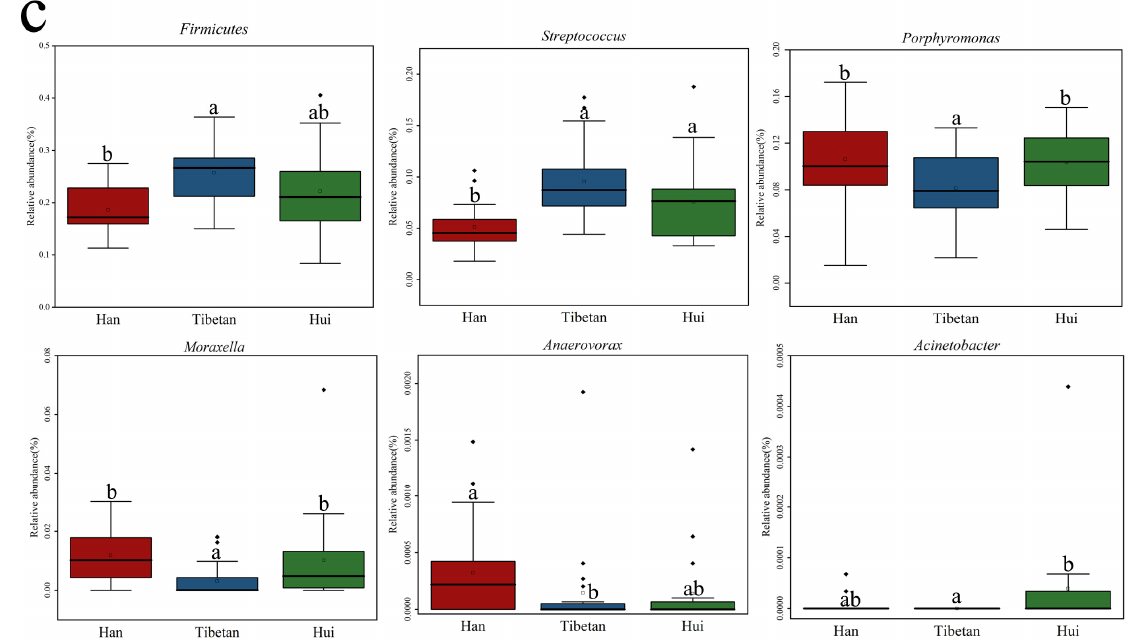
Figure 1. The composition of the oral microbiota at the ( a ) phylum and ( b ) genus levels. ( c ) The relative abundances of the significantly different taxa in the Han, Tibetan and Hui groups at the phylum and genus level. Different lower-case letters(a, ab, b,) indicate significant differences between the